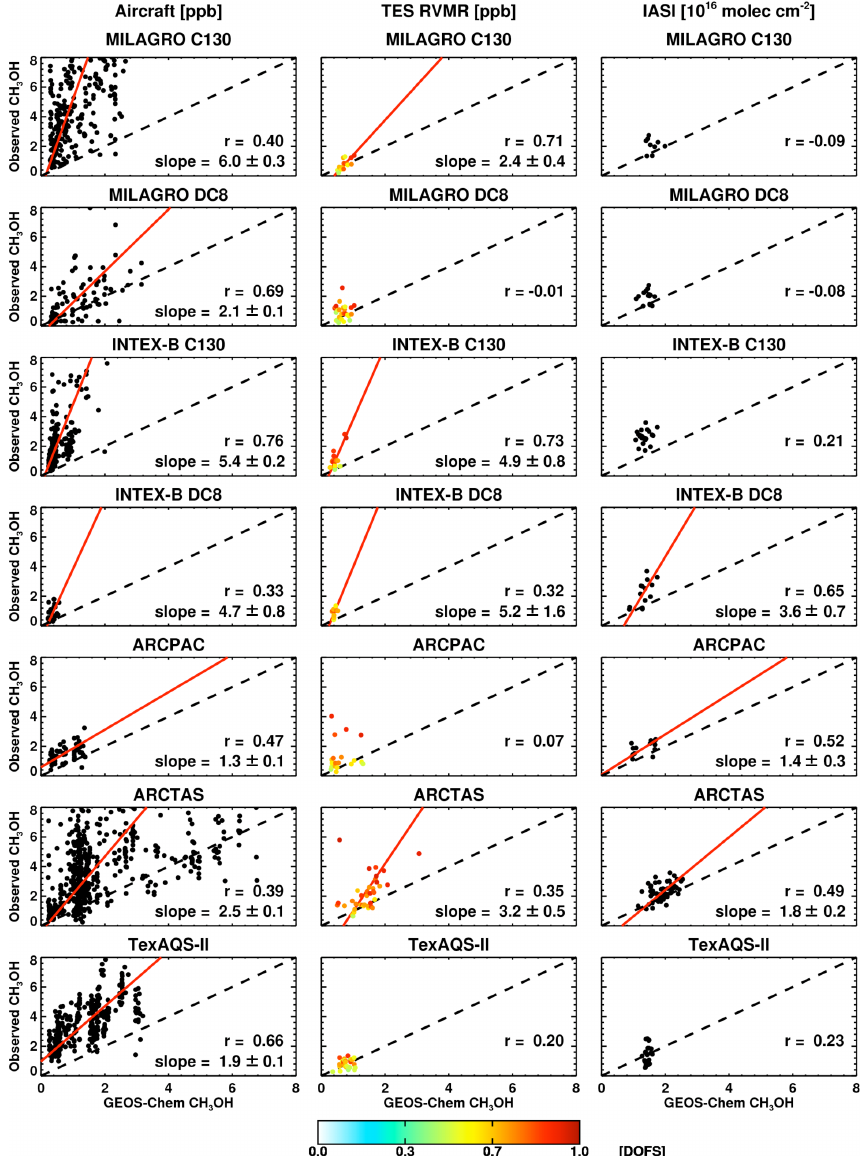
Fig. 3. Comparison of TES, IASI and airborne methanol measurements using GEOS-Chem as an intercomparison platform. Methanol abundance as modeled by GEOS-Chem (base-case simulation) is compared to aircraft (left column,ppb), TES (middle column,ppb) and IASI (right column, 10 16 moleccm − 2 ) measurements for the field campaigns shown in Fig. 2. TES data are colored according to their DOFS, and only DOFS > 0.5 are shown. Red lines correspond to a reduced major axis fit to the data (only performed for r> 0 . 25). Uncertainty estimates correspond to the standard error of the